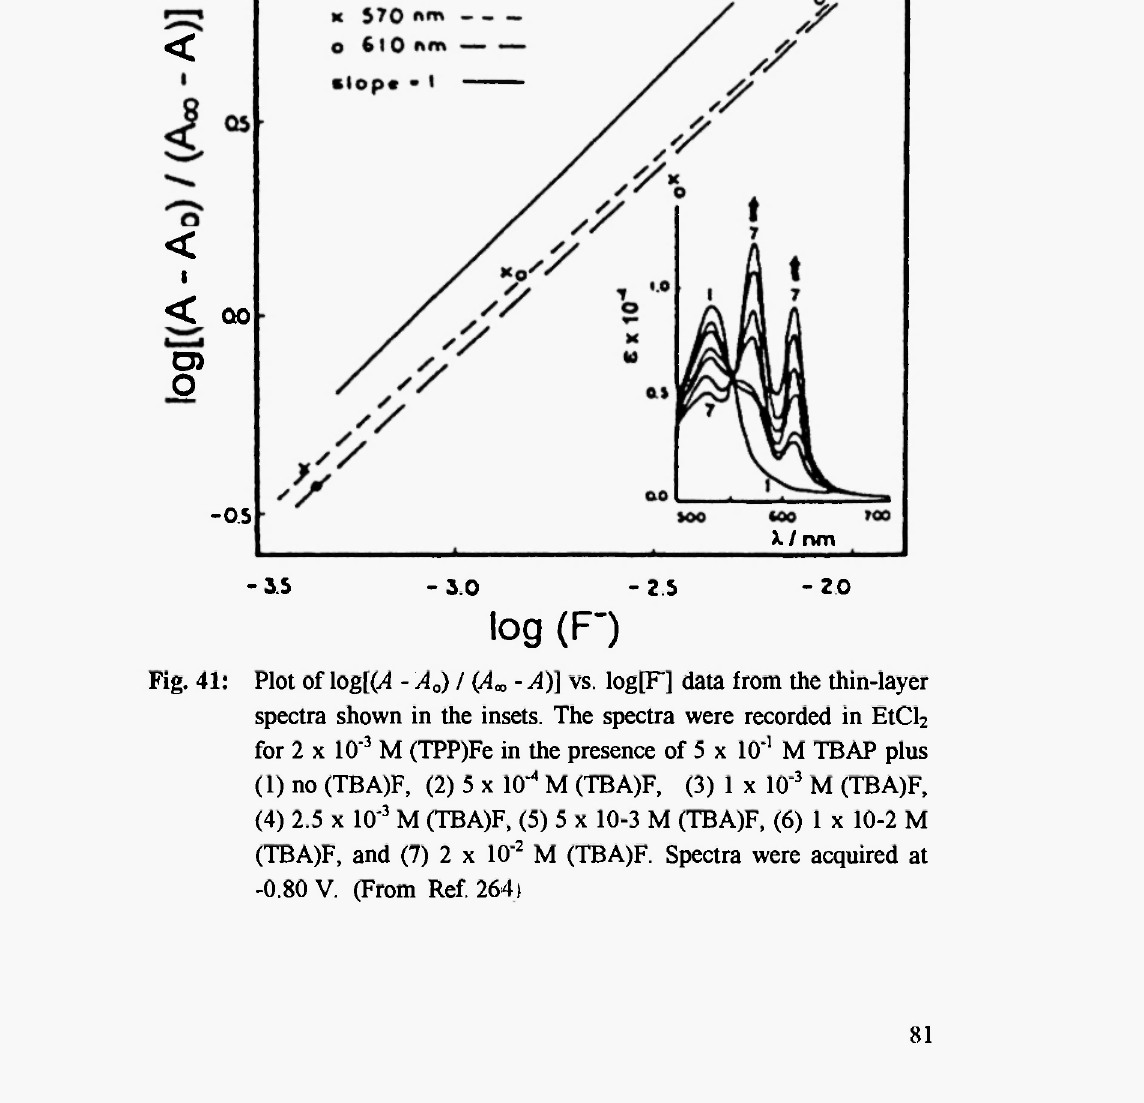
Fig. 41: Plot of log [(A - A ) / (A - A)} vs. log[F] data from the thin-layer 0 m spectra shown in the insets. The spectra were recorded in EtCl for 2 χ ΙΟ" 3 Μ (TPP)Fe in the presence of 5 χ ΙΟ" 1 Μ TB AP plus (1) no (TBA)F, (2) 5 χ ΙΟ" 4 Μ (TBA)F, (3) 1 χ ΙΟ" 3 Μ (TBA)F, (4) 2.5 χ ΙΟ" 3 Μ (TBA)F, (5) 5 χ 10-3 Μ (TBA)F, (6) 1 χ 10-2 Μ (TBA)F, and (7) 2 χ ΙΟ" 2 Μ (TBA)F. Spectra were acquired at -0.80 V. (From Ref.